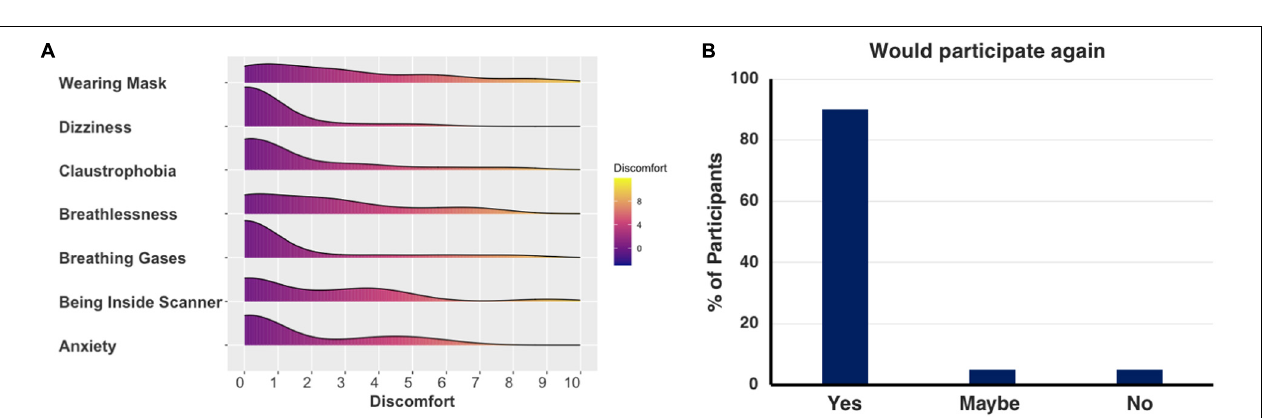
FIGURE 3 | Analysis of CVR scans. (A) The 6-min end-tidal CO 2 (EtCO 2 ) capnometry trace for a Heart and Brain Study participant. Each blue peak represents one breath and the red line follows the EtCO 2 at expiration, resampled at the TR. Participants inhaled either normocapnic air (0.04% CO 2 ) or air mixed with 5% CO 2 through a face mask. For the first 60 s participants inhaled air, followed by two alternating 75 s blocks of 5% CO 2 in air, and air. MRI data was collected from 0s. (B) Normalised and averaged EtCO 2 at each TR, used as an explanatory variable in fMRI analysis. (C) Thresholded activation images, showing a BOLD signal change during the hypercapnia blocks relative to air. Red to yellow colours represent 3.1 < z -statistic < 26.8.